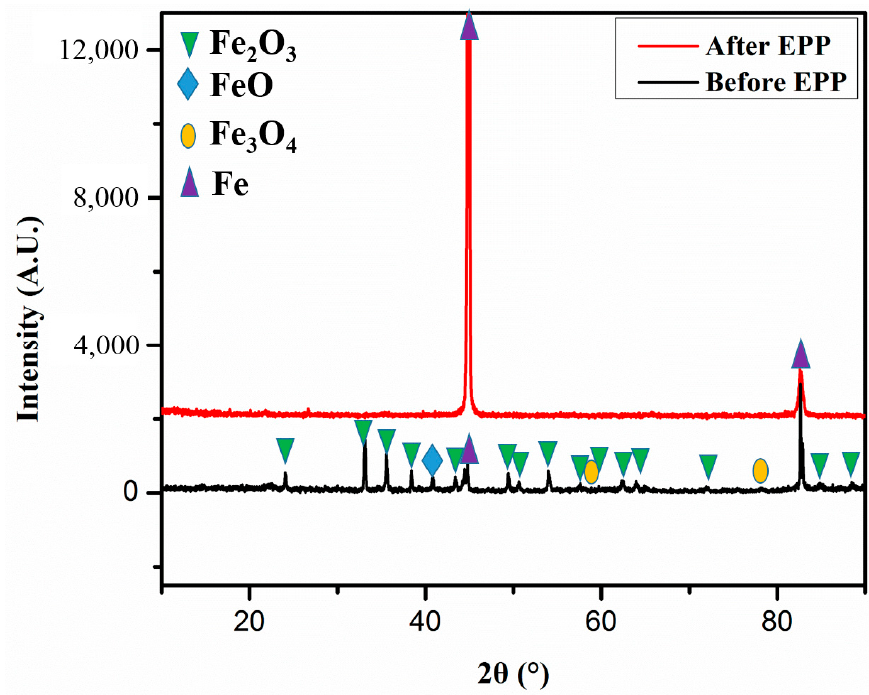
Figure 4. X-ray diffraction (XRD) pattern of Q195 carbon structural steel: Before EPP ( black curve ); After EPP treatment for 25 s ( red curve ).